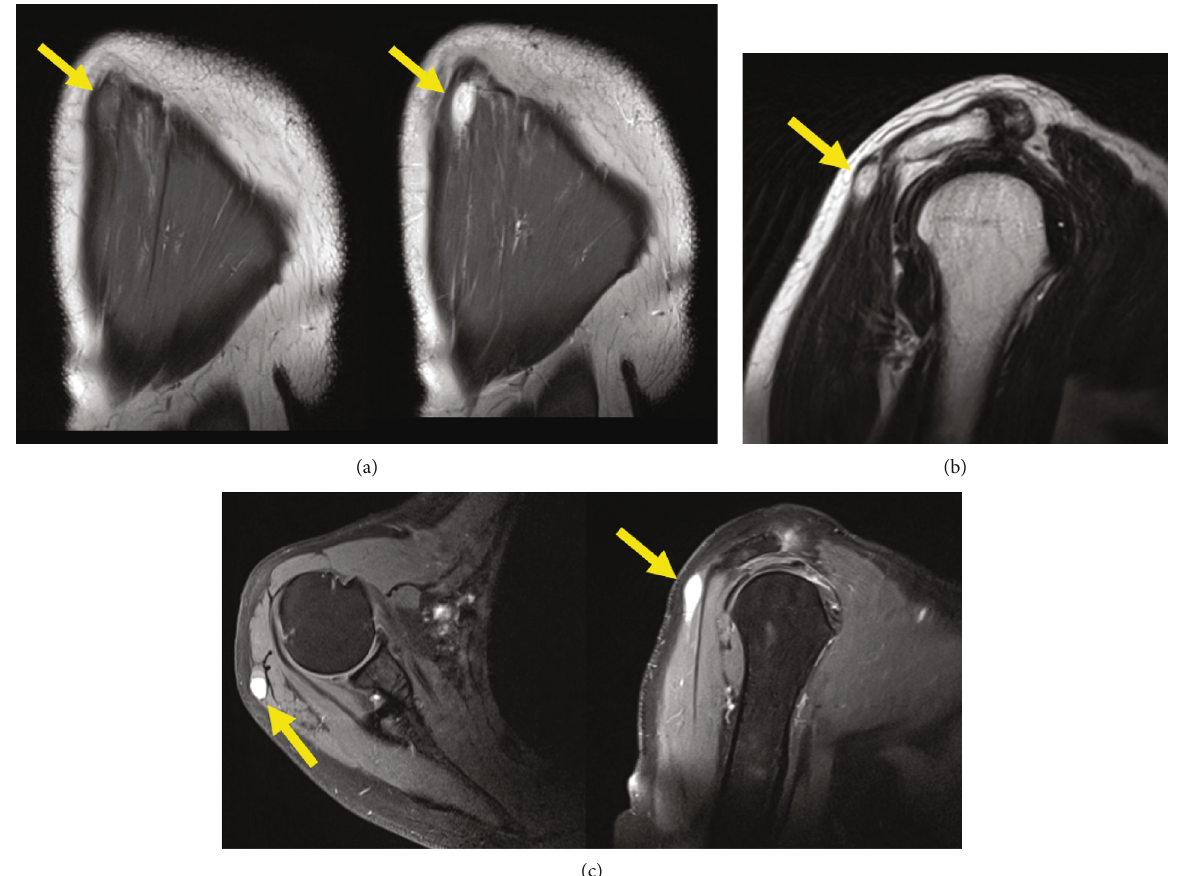
Figure 3: MRI images of the right shoulder. (a) Coronal images showing a nodular formation in the deltoid muscle (yellow arrows). The lesion is hypointense in T1 (left picture), but with strong enhancement with contrast (right picture). (b) Sagittal T2 image with turbo spin echo before contrast. The lesion appears as a hyperintense nodule (yellow arrow). (c) Axial (left) and sagittal (right) T1 images with fat suppression after contrast show a hyperintense well-limited lesion in the posterior deltoid (yellow arrows).